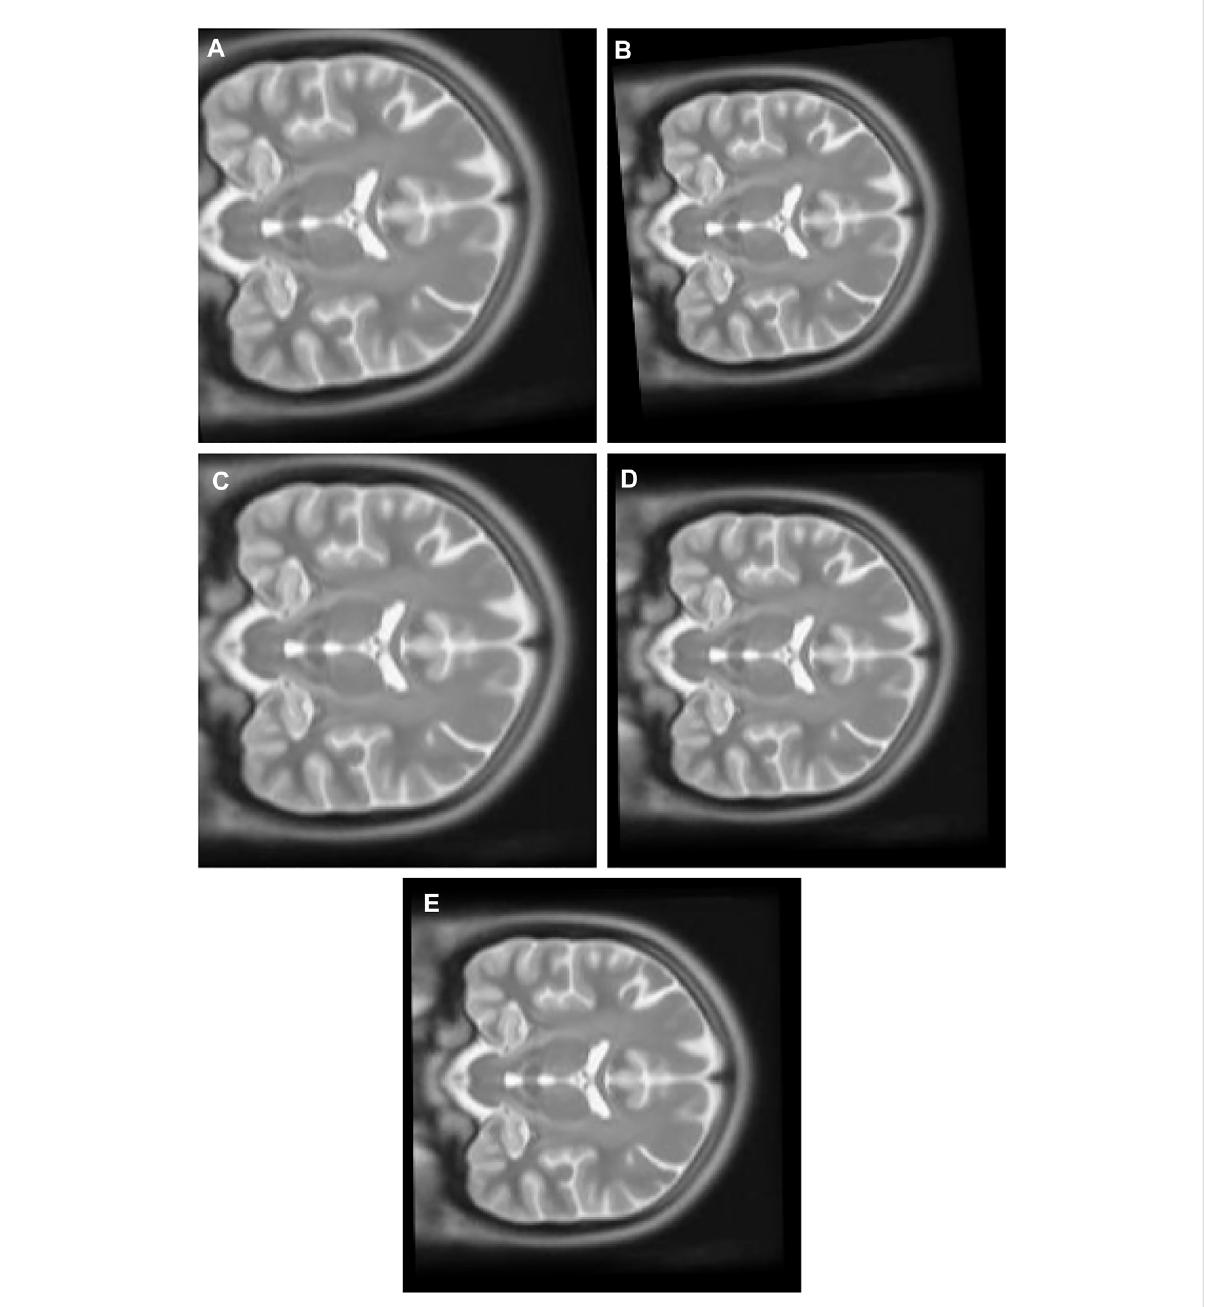
FIGURE 10 (A) Multi Modal Experiment 2 Float: row fi rst left. (B) Multi Modal Experiment 2 GA output: row fi rst right. (C) Multi Modal Experiment 2 PSO output: row second left. (D) Multi Modal Experiment 2 PSO and Powell Output: row second right. (E) Multi Modal Experiment 2 TPSysIR Output: row third